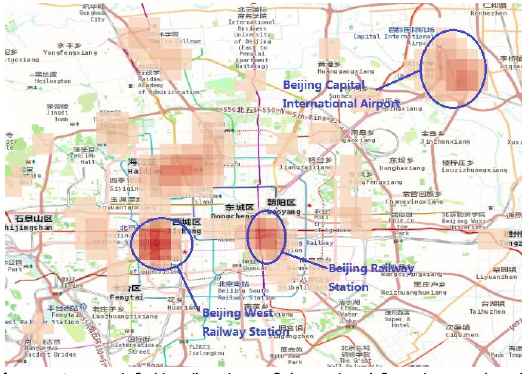
Figure 4. spatial distribution of the microblogging under the topic related to